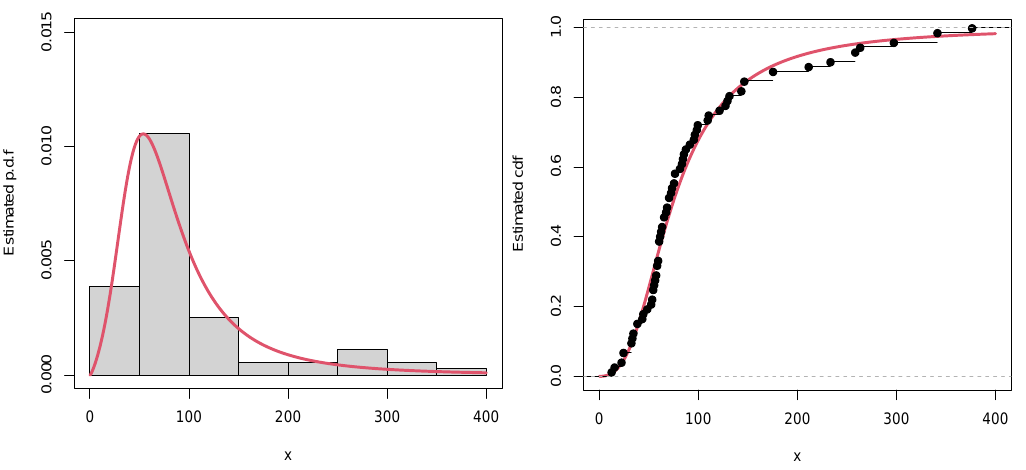
Figure 8. Estimated p.d.f ( left ) and CDF ( right ) of the GAEPPR model corresponding to strength glass fiber data.